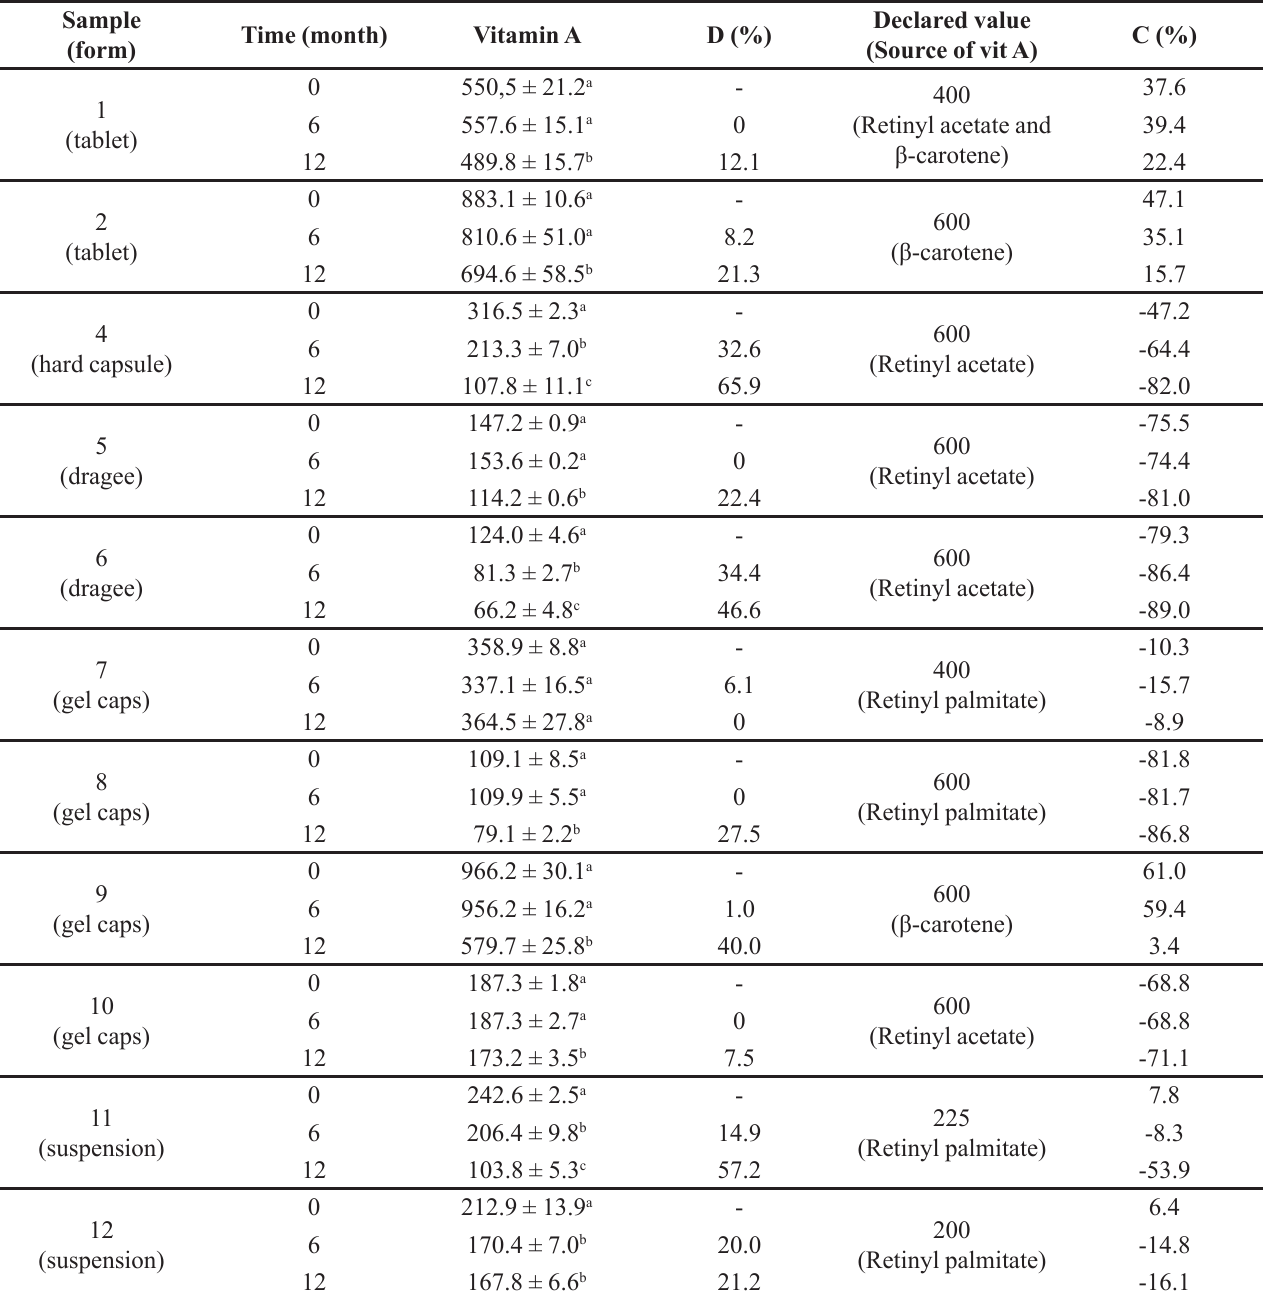
TABLE II - Analysis of vitamin A (µg RE/serving) in supplements during storage